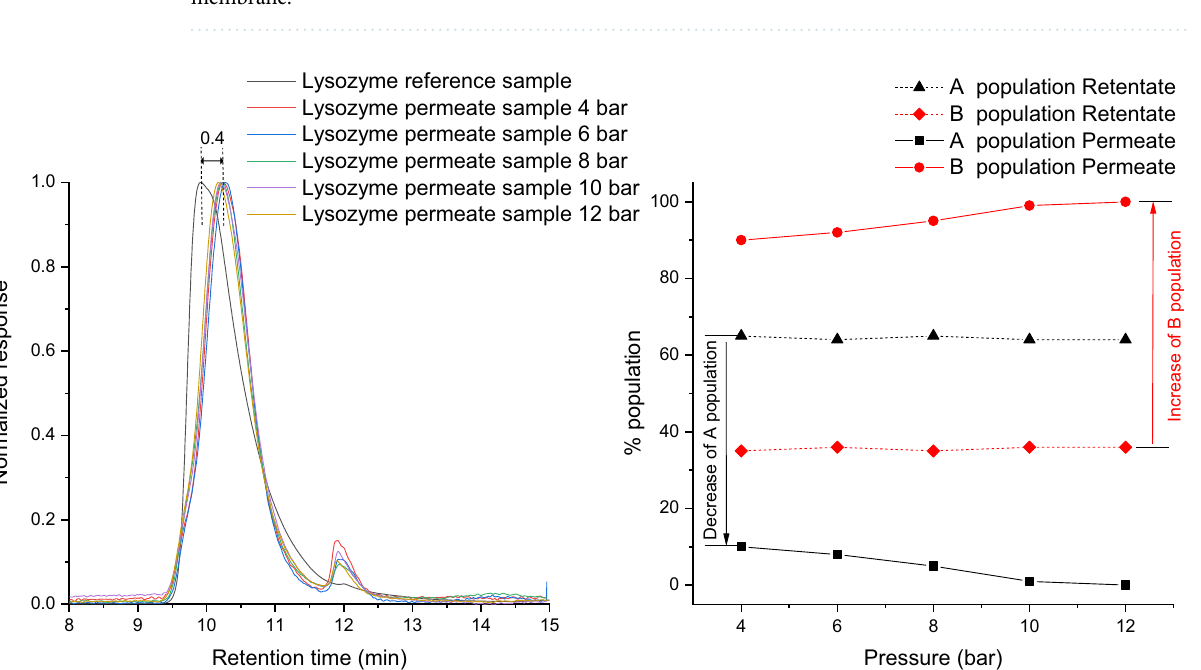
Figure 3. Normalized chromatograms of permeate samples (left) and population distribution (right) for M1Reg and/or M2Reg